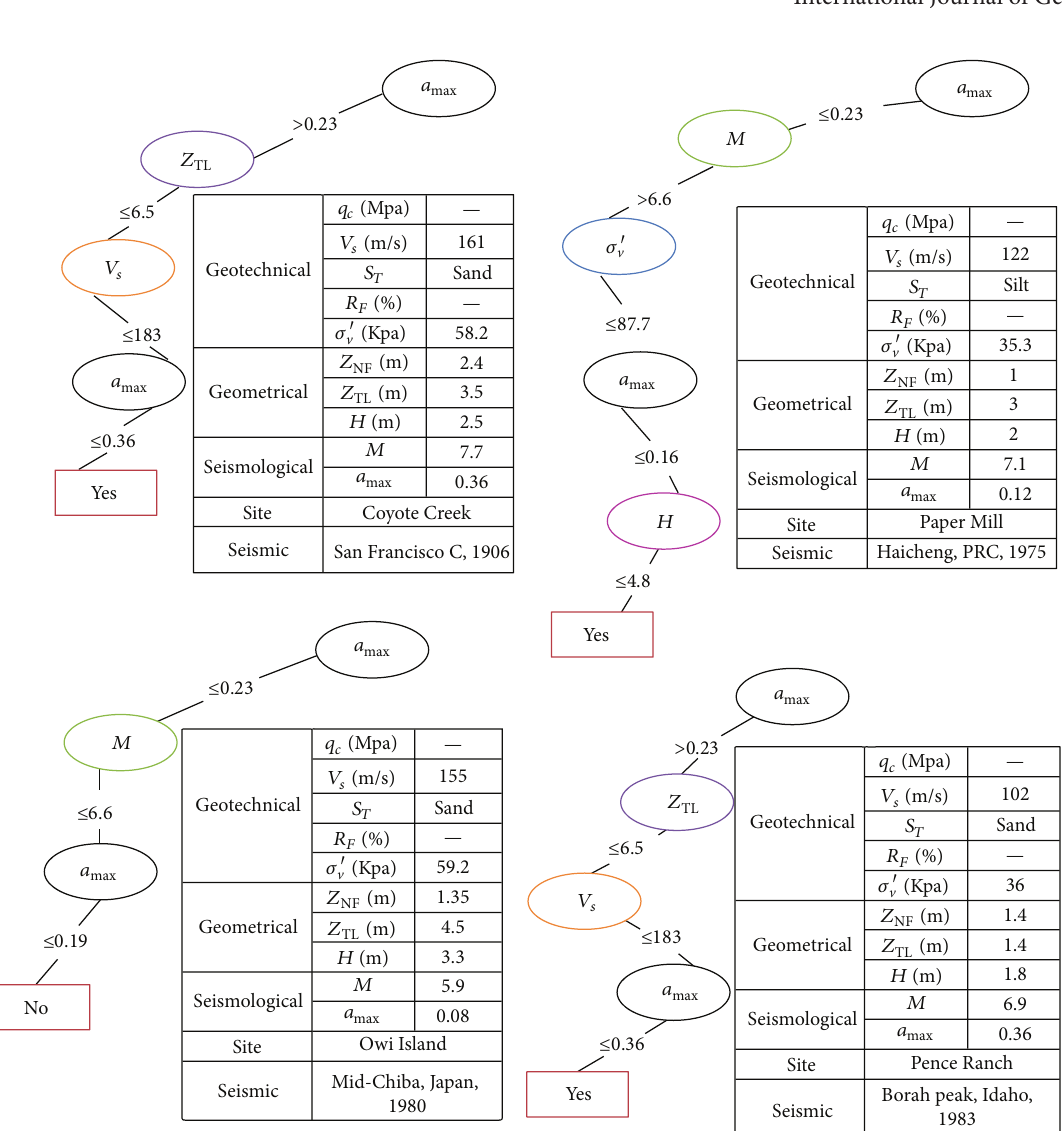
Figure 24: Validation tests: using 𝑉 𝑠 as geotechnical